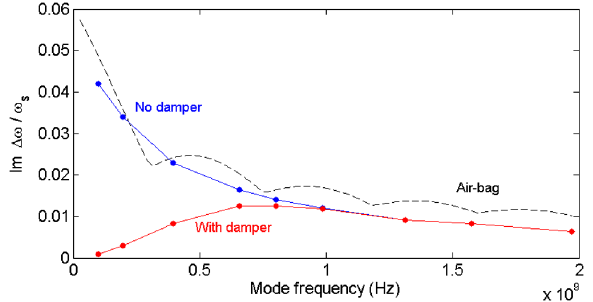
(with the tails cut at 3 . 2 σ ) is narrower than the one for the rms Gaussian profile (with infinitely long tails), leading to a higher octupole threshold for the modes that have a large negative real tune shift. Stability diagrams computed for E ¼ 7 TeV, β (cid:1) ¼ 41 cm and maximum negative octupole current of I ¼ − 570 A, oct rms beam emittances.